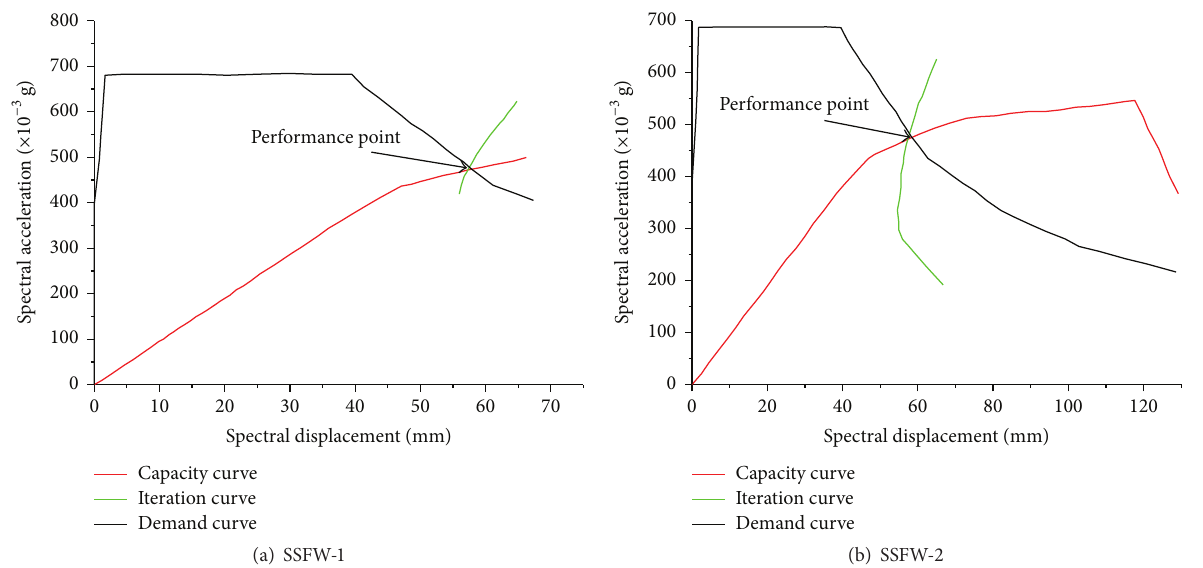
Figure 21: Performance point of the different structures under rare earthquake conditions.